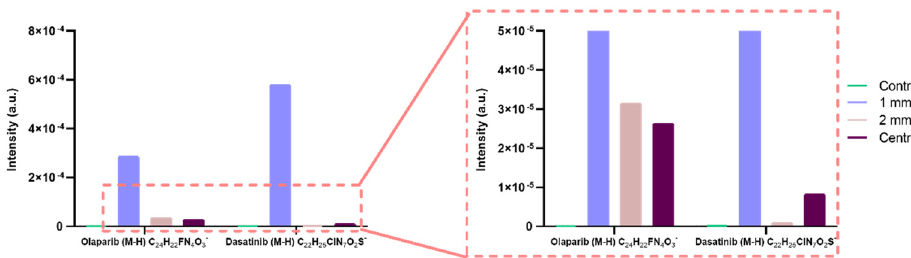
Figure 4. Dual detection of olaparib and dasatinib in a coronal section of a mouse brain. Samples were taken at 1 mm increments distal from the administration site, plus the centre of the coronal section, showing their molecular ions (M-H) − with a deviation of <2 ppm. A mouse brain control section was also analysed for comparison, showing no peak for the molecular ions.